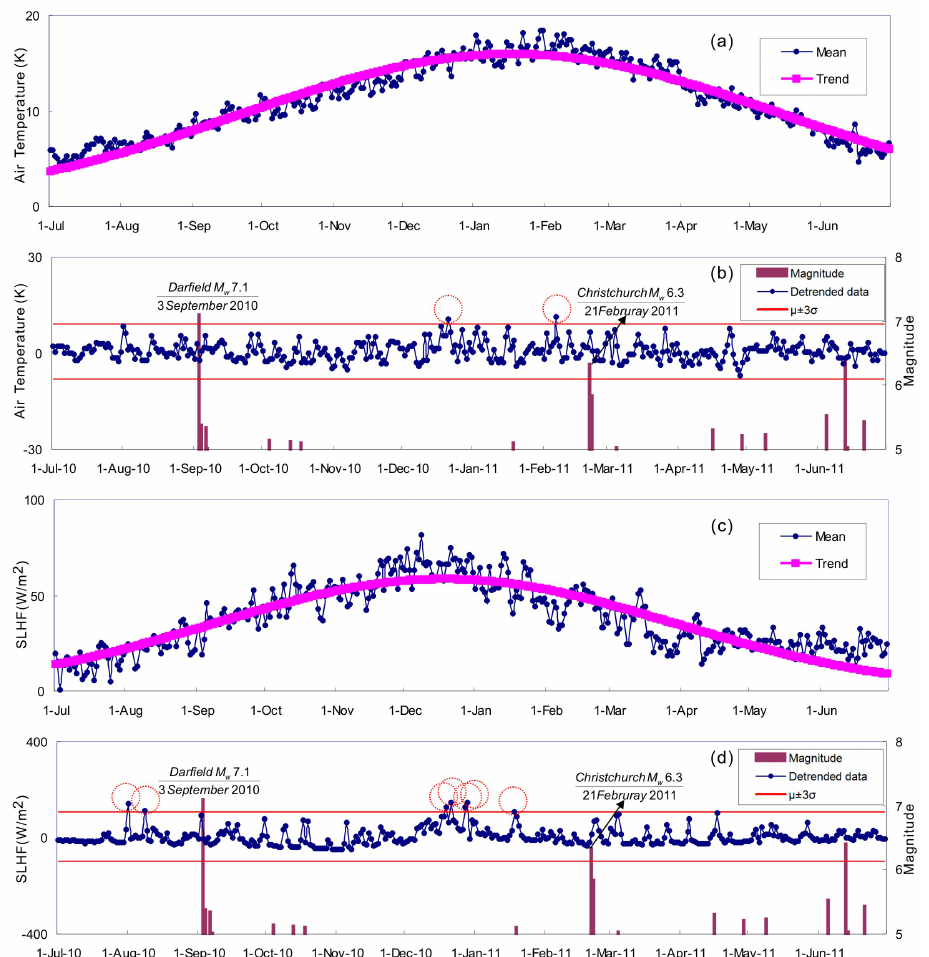
Fig. 3. Time series of air temperature from the weather station NZCH near the epicenter and of SLHF data on the epicenter pixel (42.86 ◦ S 172.5 ◦ E). The brown columns indicate the mainshock and aftershocks ( M > 5) and the red circles indicate the outliers exceeding µ+3 σ . (a) shows the multiple year (1996–2011) mean values of air temperature and trend curve obtained by the Gaussian fitting (Gaussian func- i 2 h x − b 1 − c 1 , a1=15.95(15.77, 16.13), b1=201.2(199.6, 202.8), c1=165.8(163, 168.7), R-square:0.9306). (b) shows the tion: f (x) = a 1 ∗ e detrended data of air temperature from 1 July 2010 to 30 June 2011. (c) shows the multiple year (1980–2011) mean values of SLHF and trend − curve obtained by the Gaussian fitting (Gaussian function: f (x) = a 1 ∗ e (152.9, 162.2), c1=94.77(82.03, 107.5), a2=27.75( − 65.35, 120.9), b2=665.5( − 2678, 4009), c2=661( − 1505, 2827), R-square:0.8442). (d) shows the detrended data of SLHF from 1 July 2010 to 30 June 2011.